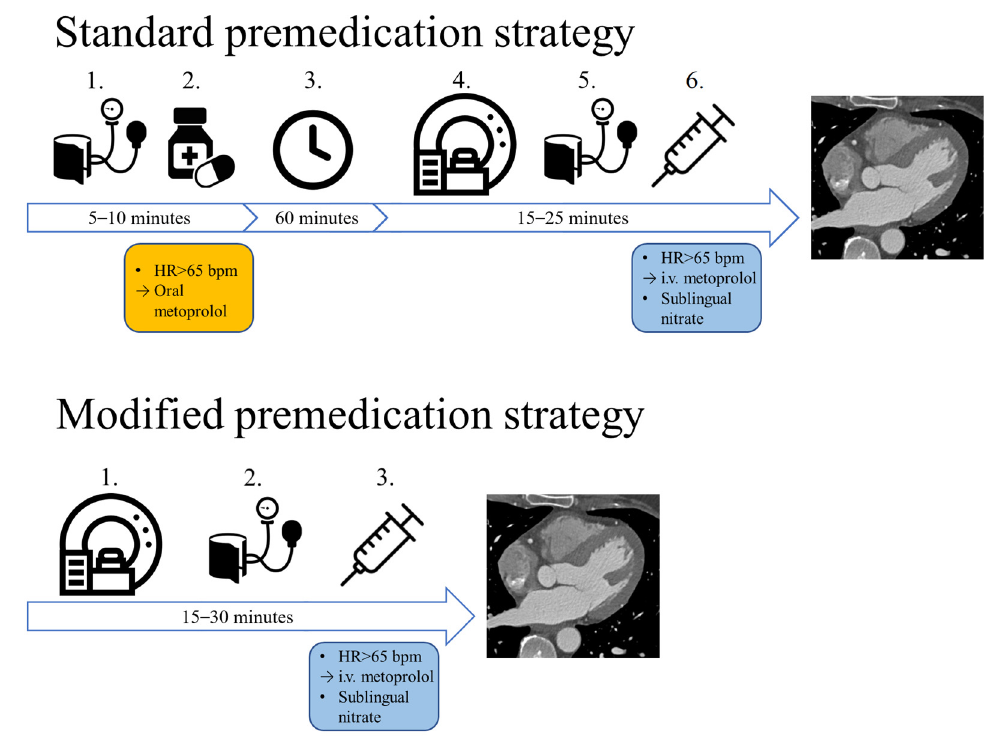
Figure 1. The two different premedication strategies: with the standard approach, if the patients’ heart rate is above 65 bpm, oral metoprolol is administered, which is followed by a 1 h wait. If afterwards the HR is still not optimal, i.v. metoprolol is administered right before image acquisition. With our modified premedication strategy, no oral medication is administered, only i.v. metoprolol is administered before the CTA scan. HR: heart rate, bpm: beats per minute, i.v.: